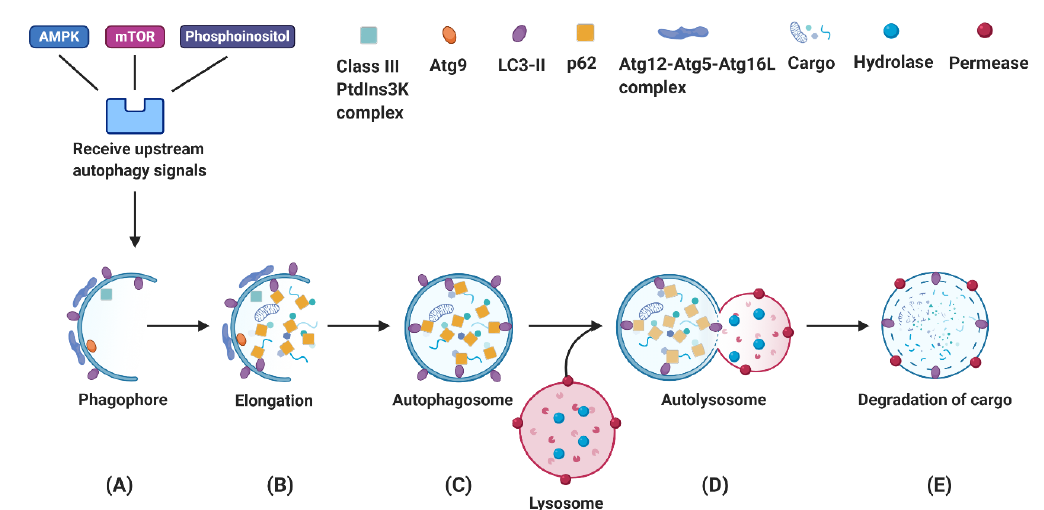
Figure 2. The dynamic process of autophagy. Macroautophagy mainly includes the following steps: ( A ) Phagophore formation. Activation of the Class III PtdIns3K complex produces PI3P, which facilitates the nucleation of phagophores and regulates the degradation of autophagy cargo [106]. ( B ) Phagophore elongation and capture of degradation targets. The function of the transmembrane protein Atg9 is to deliver the membrane from donor organelles to the expanding phagophore [107]. The LC3-II and Atg12–Atg5–Atg16L complex promotes phagophore elongation [106]. ( C ) Autophagosome formation. p62 interacts with the autophagy cargo and delivers it to the autophagosome. ( D ) Fusion of the autophagosome with lysosome; ( E ) Degradation of the cargo.